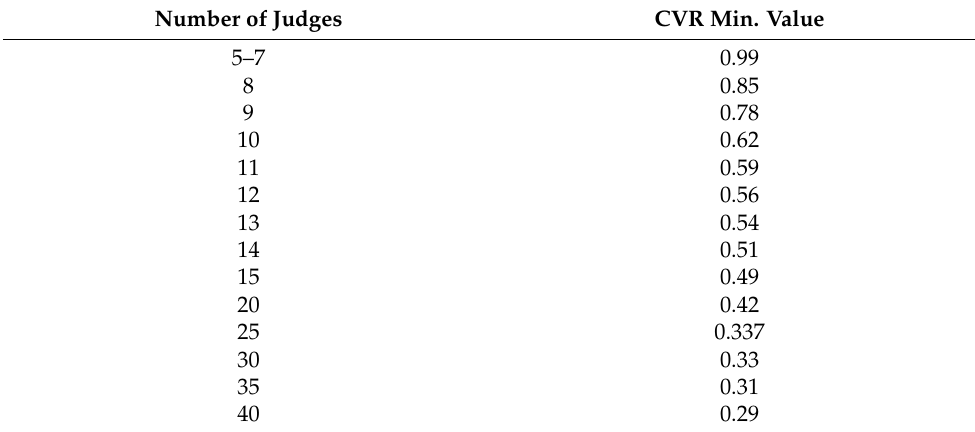
Table 1. Minimum values of CVR . Number of Judges CVR Min.